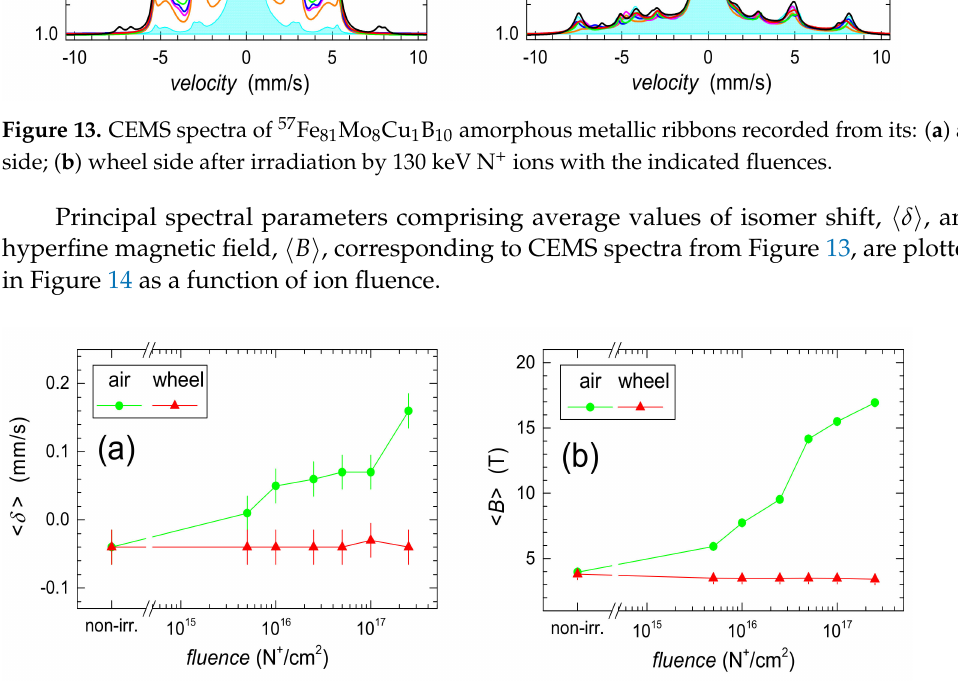
Figure 14. Parameters derived from CEMS spectra recorded from the air (green circles) and wheel (red triangles) sides of the ribbons of 57 Fe 81 Mo 8 Cu 1 B 10 irradiated by 130 keV N + ions plotted against the ion fluence: ( a ) average isomer shift, (cid:104) δ (cid:105) ; ( b ) average hyperfine magnetic field, (cid:104) B (cid:105) . Solid lines are only guides for the